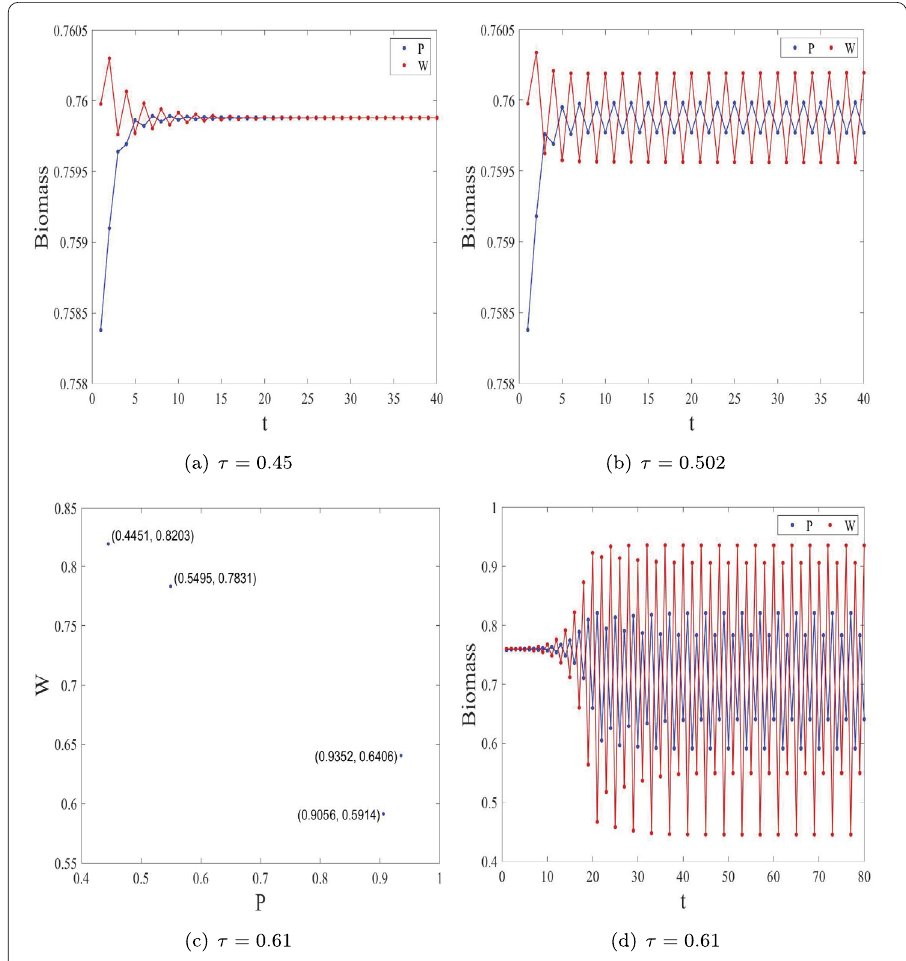
Figure 3 Dynamics of the plant and wrack biomass changing over time for various values of parameter τ